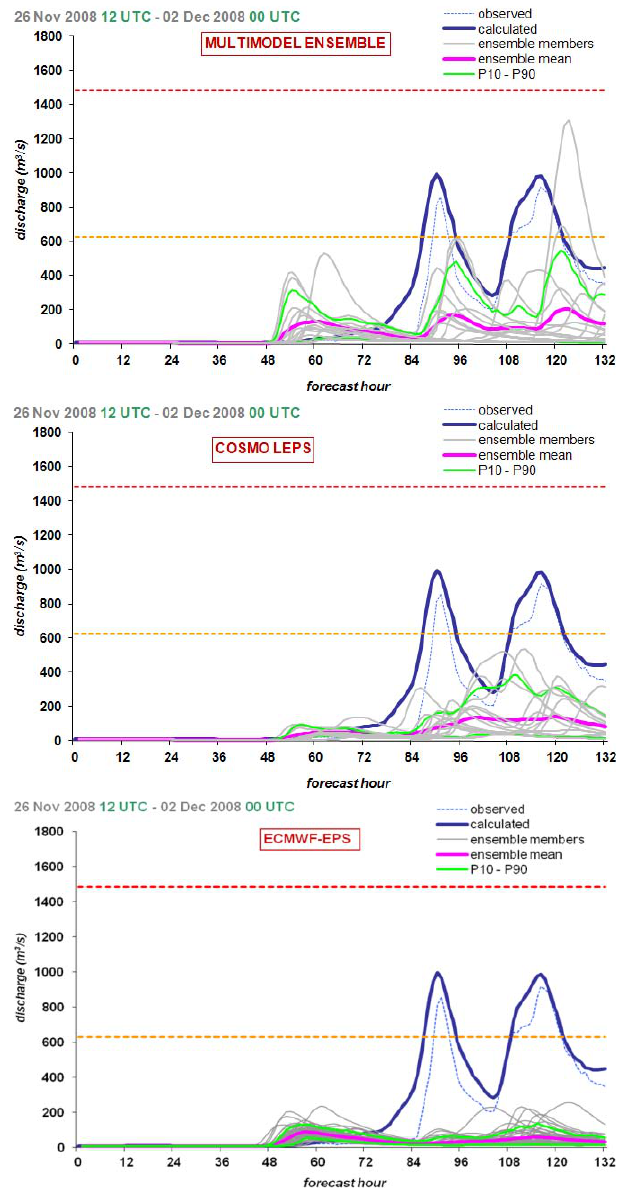
Figure 4. Discharge forecast (m 3 s − 1 ) vs. forecast range (hours) for multi-model, COSMO-LEPS and ECMWF EPS (51 members), respectively, initialized at 12:00UTC, 26 November 2008. Each grey line corresponds to an ensemble member. For reference, the observed discharge (dotted blue) and the discharge computed using rainfall observations are provided. Ensemble mean (pink) and the P10-P90 curves (green) are also plotted. Horizontal dashed orange and red lines indicate warning and alarm thresholds,